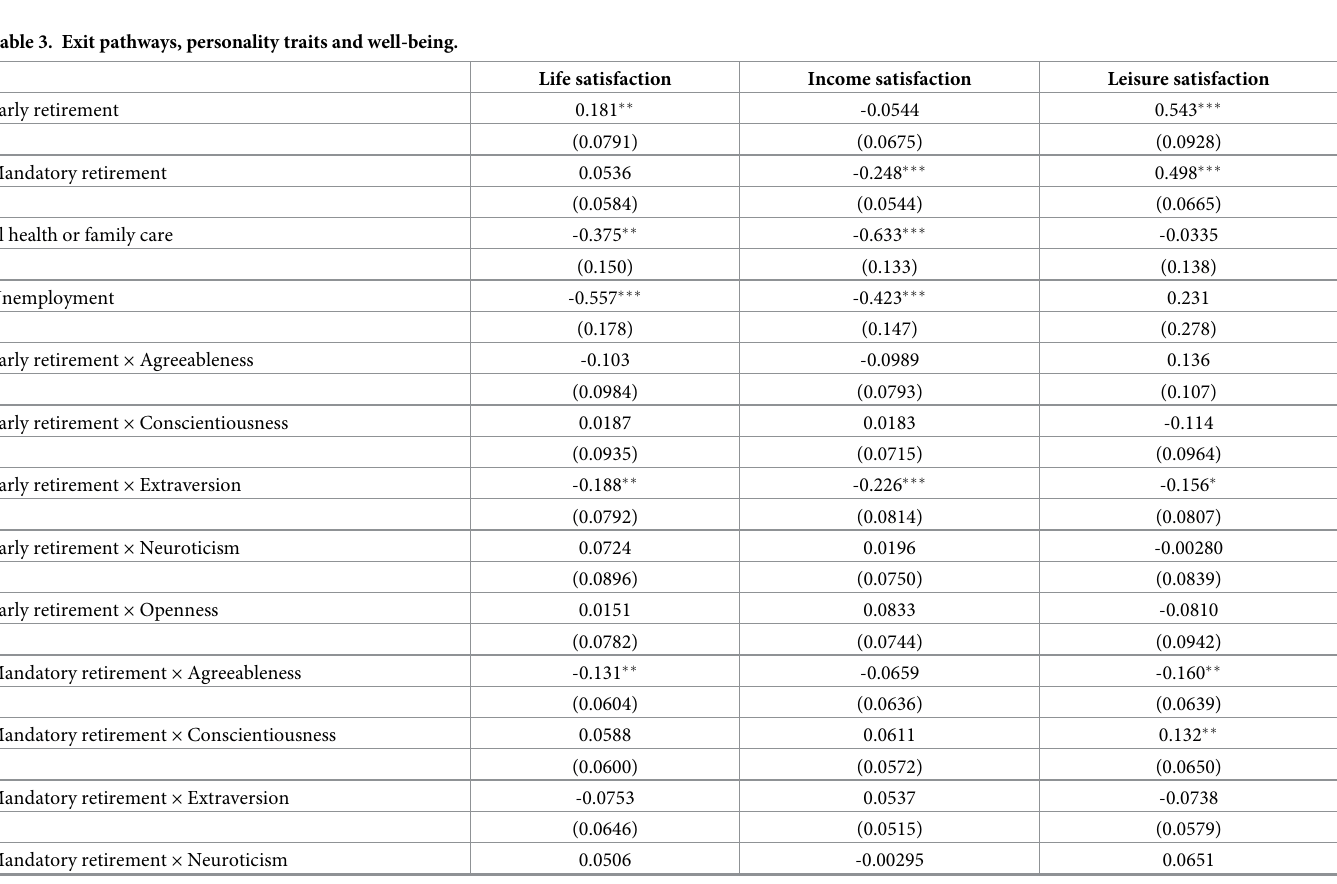
Table 3. Exit pathways, personality traits and